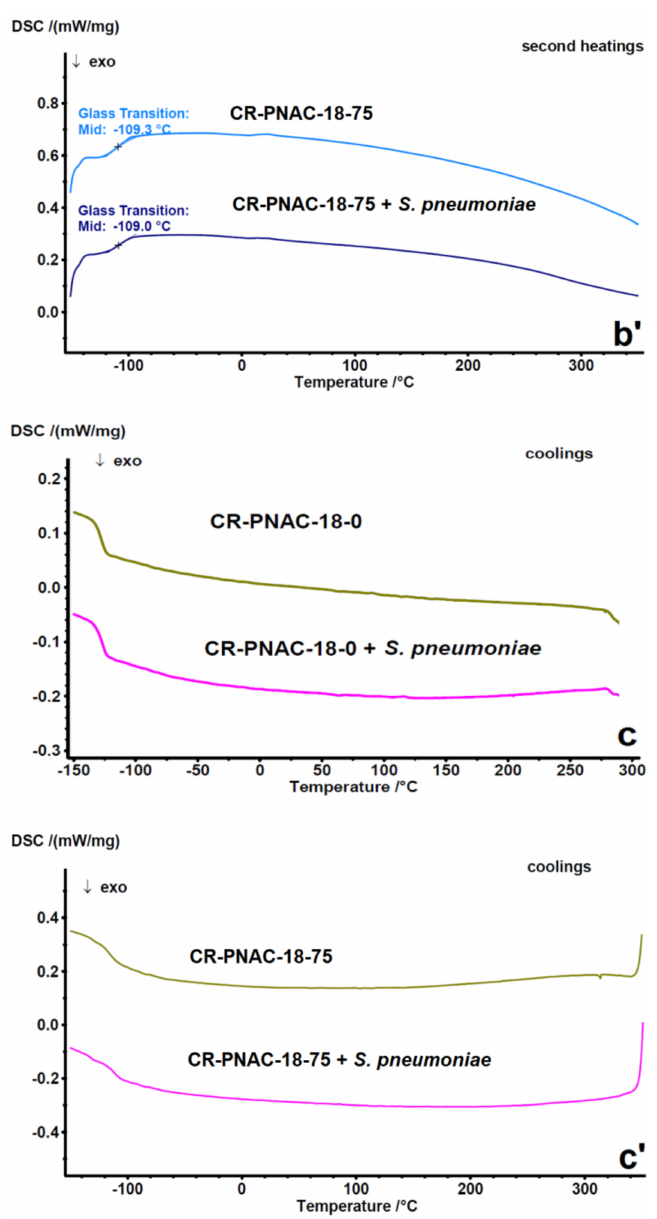
Figure 6. DSC curves of CR-PNAC-18-0 and CR-PNAC-18-75 before and after contact with S. pneumoniae : ( a , a’ ) first heatings; ( b , b’ ) second heatings; and ( c , c’ )